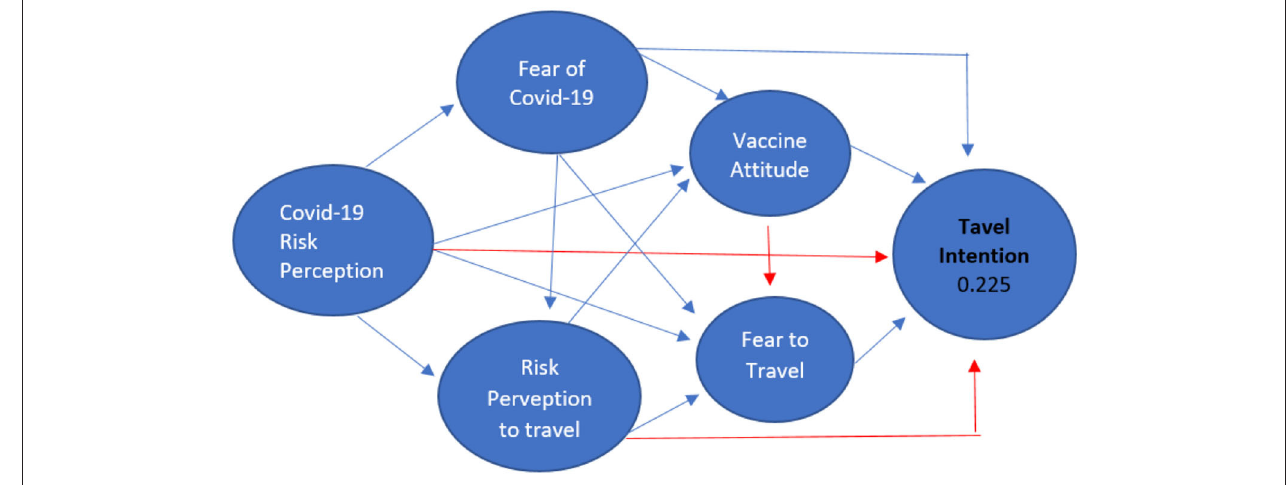
FIGURE 2 | Indonesia travel intention research results.